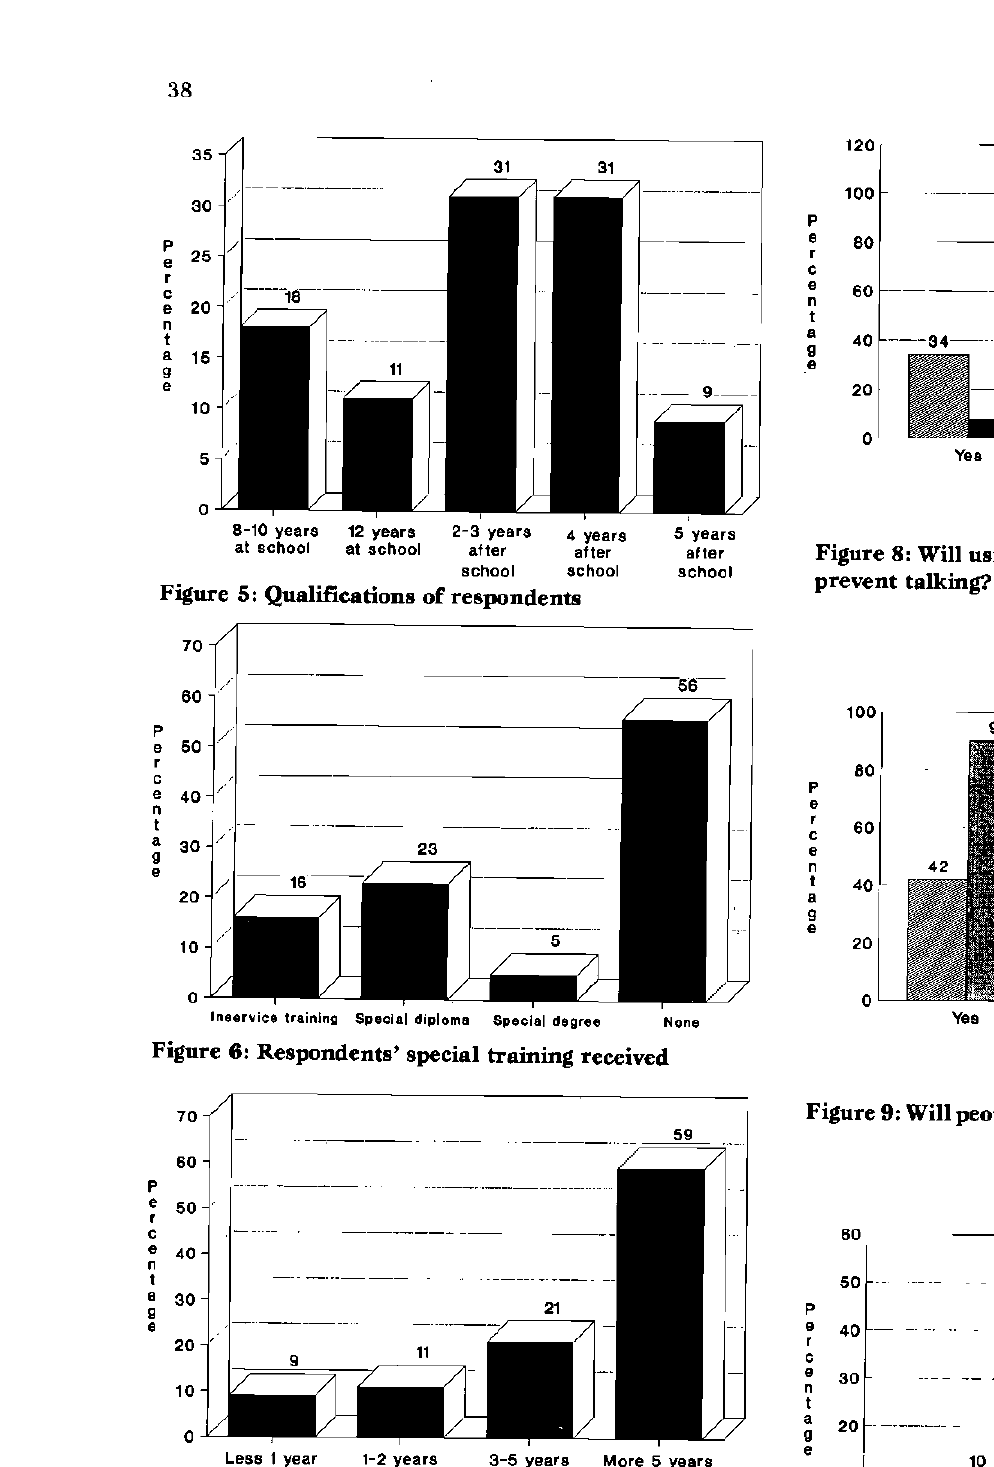
Figure 7: Respondents' exposure time to disabled people